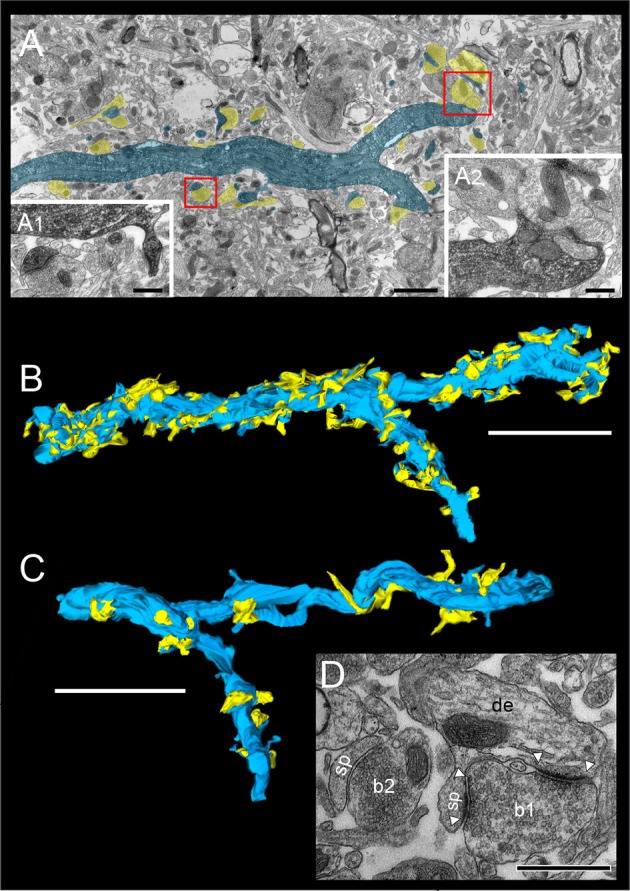
Distribution of L5B synaptic boutons on HRP-filled dendritic segments. (A) Low power electron micrograph showing the distribution of synaptic boutons (transparent yellow) on an HRP-filled dendritic segment (transparent blue) of the postsynaptic neuron shown in Figure 1A. Note the high density of synaptic inputs terminating on this dendritic segment. Scale bar: 5 μm. (A1) Synaptic boutons terminating on HRP-labeled spines (framed area in A on the left), (A2) Two shaft synaptic boutons at the HRP-labeled dendrite (framed area in A on the right). Scale bars in (A1,A2) 0.25 μm. (B) 3D-volume reconstruction of the dendritic segment shown in (A). The dendrite is given in blue, terminating synaptic boutons in yellow. Note the different shape, size and dense distribution of synaptic boutons (n = 199) Scale bar: 2.5 μm. (C) Another basal dendritic segment (blue) with a much lower number of synaptic boutons (yellow). Scale bar: 2 μm. (D) High power electron micrograph of a synaptic bouton (b1) on both the spine head (sp) and dendritic shaft (de) and an adjacent bouton (b2) terminating on a different spine (sp). AZs are marked by arrowheads. The image was taken in the surrounding neuropil of the HRP-filled pair of neurons. Scale bar: 0.5 μm.